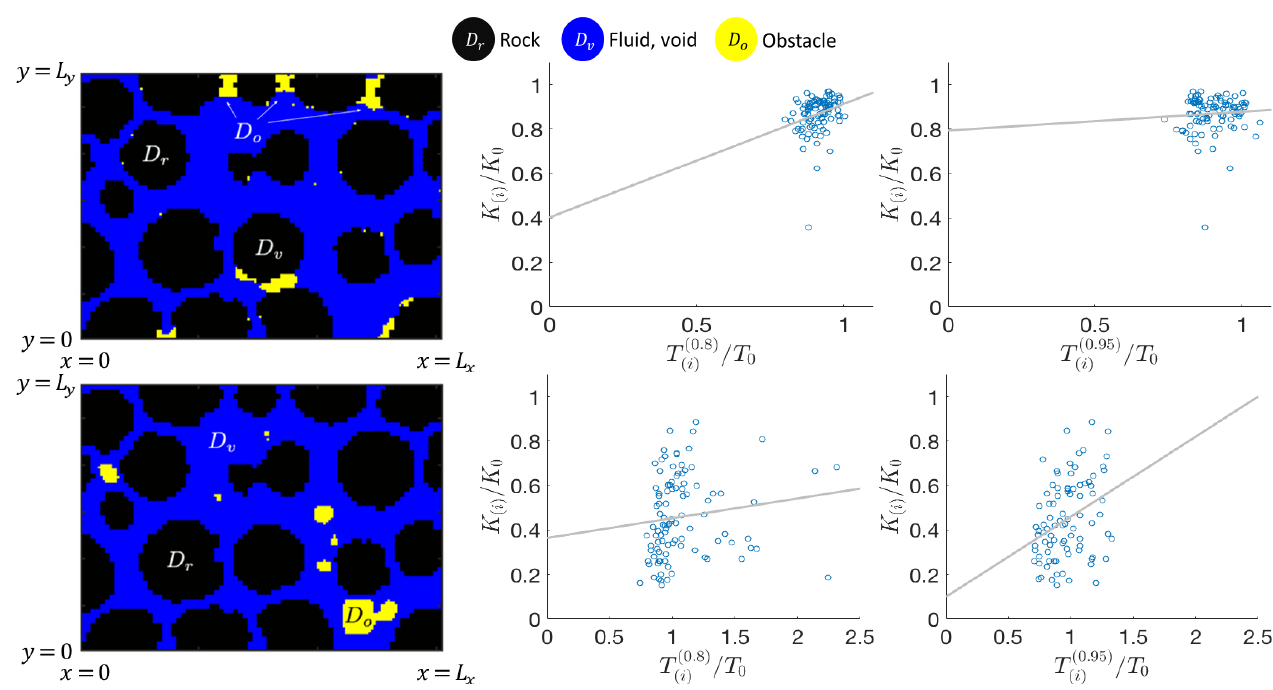
Figure 25. Transport properties with geometries D o obtained with LP model in Example 3. Top row: pore-coating, and bottom row: pore-filling geometries, Left: many-pore geometry with V o = 0.05. Middle and right: relative change in K against the relative change in T ( α ) with α = 0.8, and α = 0.95,